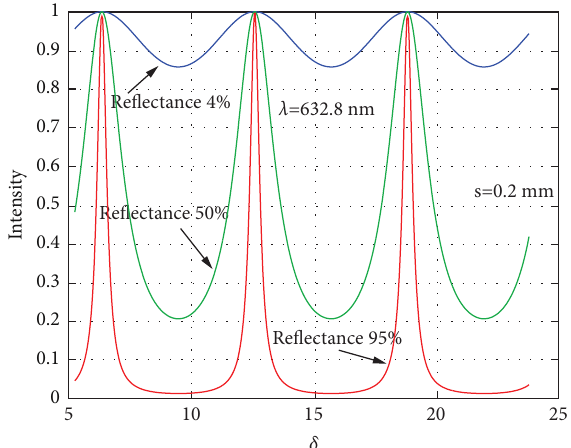
Figure 2: Transmitted intensity as a function of δ for a F - P in- terferometer where a wavelength of 632.8nm has been considered. Te parameter is the mirrors’ refectance.